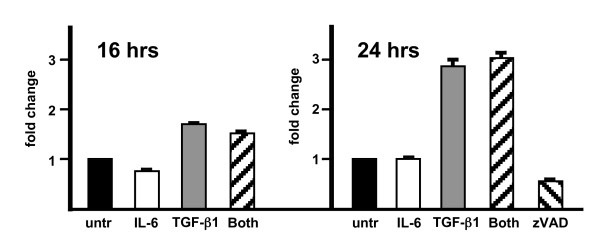
Caspase-3 activity in LCL8664 cells treated with IL-6 and/or TGF-β1. LCL8664 cells were treated with IL-6 (20 ng/ml), TGF-β1 (1 ng/ml), both, or were untreated (untr) for 16 or 24 hours. Parallel samples were treated with the broad caspase inhibitor, zVAD-fmk (zVAD) as a negative control. Caspase-3 activity was quantified in whole cell lysates using a colorimetric assay. The data are reported as fold-change in caspase-3 activity relative to untreated samples.